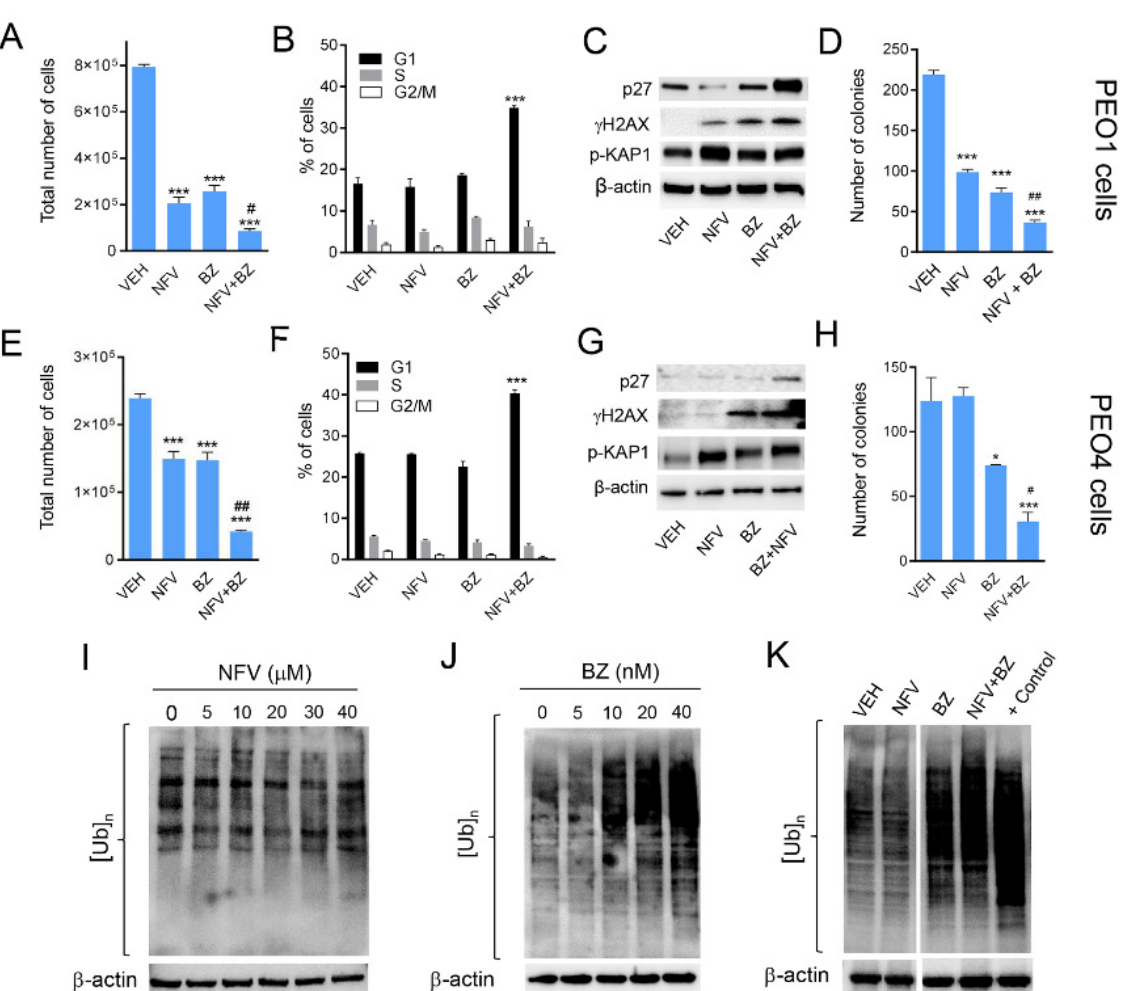
Figure 6. PEO1 and PEO4 were exposed to a combination of NFV and the proteasome inhibitor bortezomib (BZ) predicted to be synergistic in the drug interaction studies. Thus, PEO1 were ex- posed to 10 µM NFV, 10 nM BZ, or a combination of 10 µM NFV and 10 nM BZ. PEO4 instead received 5 µM NFV, 5 nM BZ, or the combination of 5 µM NFV and 5 nM BZ. In both cell lines, treatments lasted 72 h. Total number of PEO1 ( A ) or PEO4 ( E ) cells were assessed using a viability